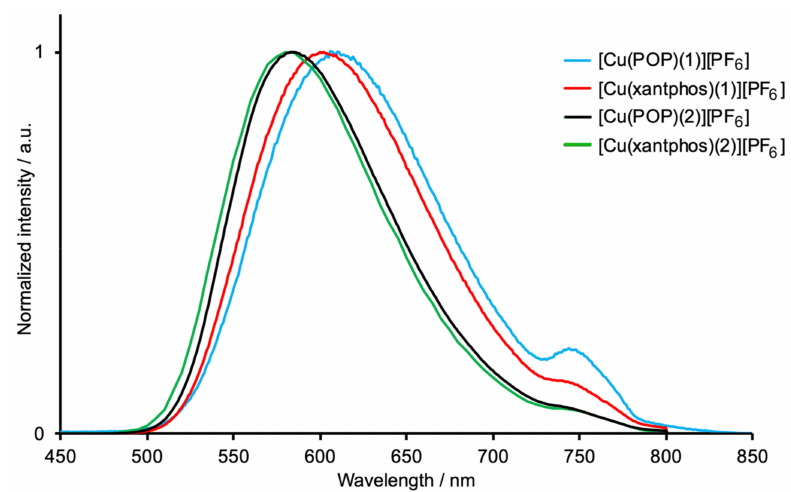
Figure 10. Normalized solid-state emission spectra of the compounds ( λ exc = 365